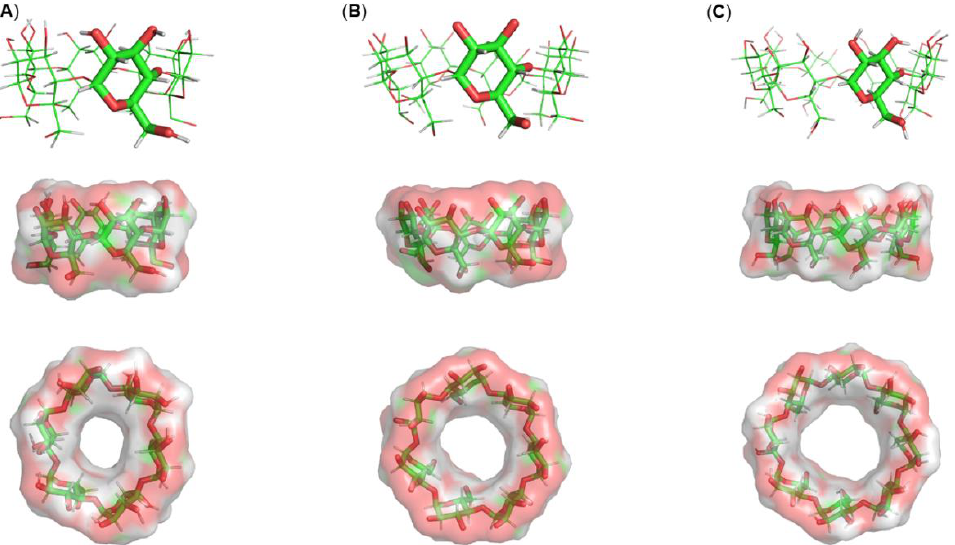
Figure 1. Molecular structures and three-dimensional side and top views of: ( A ) αCD, ( B ) βCD and ( C ) γCD. The surfaces shown represent the solvent-accessible surface areas (SASAs) in regard to water. Colors by atom-type indicate the regions of the molecule that are accessible (red: oxygen; grey: carbon). SASAs were calculated using cyclodextrin structures deposited in the Cambridge Crystallographic Data Centre under 1100537, 1107195 and 1126611 deposition numbers for αCD, βCD and γCD, respectively. The image was prepared using Pymol v.2.1 and in-house developed Python scripts.